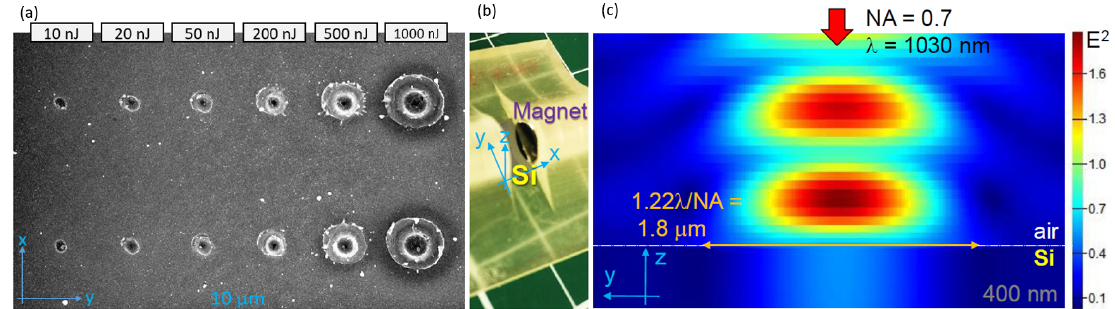
Figure 4. ( a ) Ablation of Si at different pulse energies where no magnetic field is applied B = 0 with polarisation of light along y-axis, (at the entrance of the objective lens of numerical aperture NA = 0.7; transmission of the lens was T = 0.22). For the tilted-SEM view see Supplementary Figure A1 and Figure A2. ( b ) Optical image showing the placement of Si in the central part of magnetic B-field. ( c ) Finite difference time domain (FDTD) simulation (Lumerical) of light intensity distribution at the plane of incidence at the conditions of experiments. Modelling presents a linear light intensity distribution. The amplitude of the light source E y =